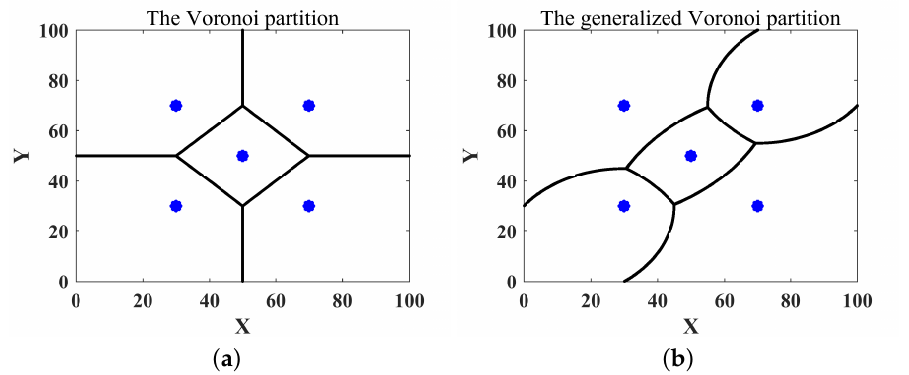
Figure 1. The Voronoi partition based on the proximity principle ( a ) and the generalized Voronoi partition based on the shortest time principle ( b ) (where the blue point “ • ” represents the position of the robot, and each robot had a different maximum speed v i _max ( i ∈ V )